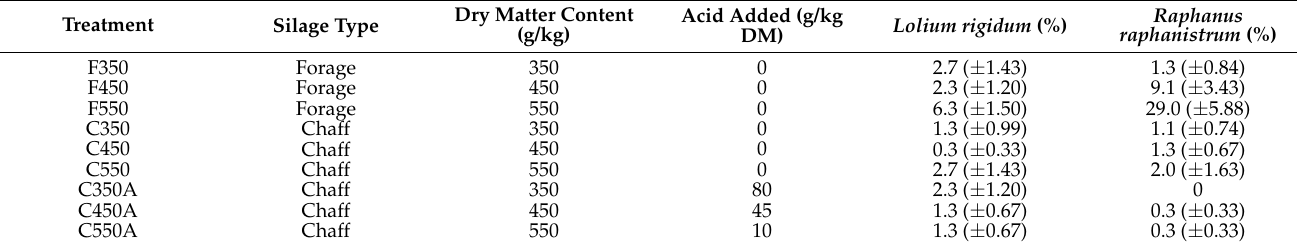
Table 4. Viability (%) of Lolium rigidum L. and Raphanus raphanistrum L. seeds following ensiling in Medicago sativa L. forage wilted to achieve different dry matter contents or chaff with water and acid added to achieve a similar dry matter content.